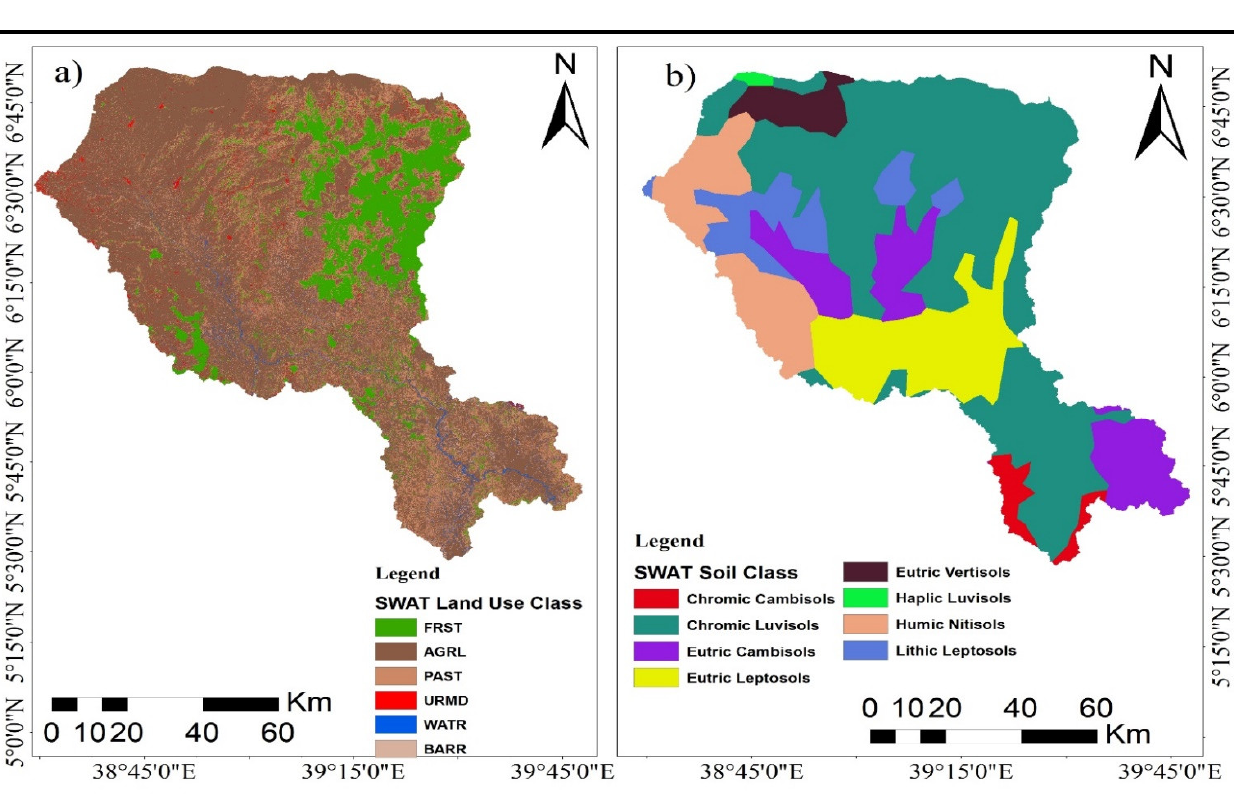
Figure 2. ( a ) Land use map; ( b ) soil map of the study area.